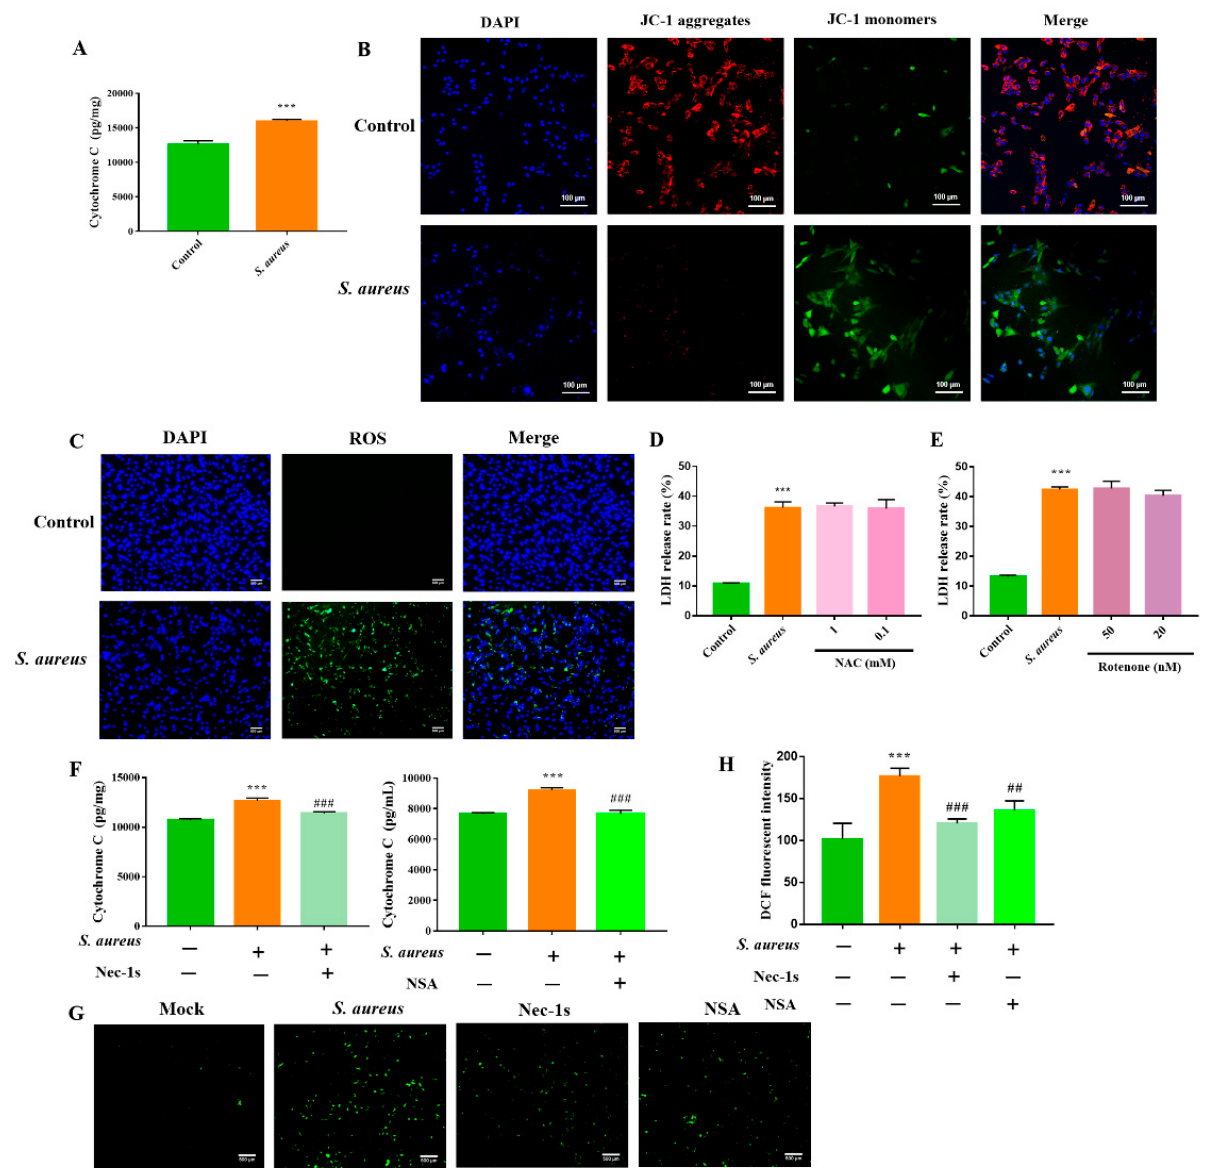
Figure 5. gEEC necroptosis aggravated the mitochondrial damage and ROS generation induced by S. aureus . ( A ) gEECs were infected with 10 MOI S. aureus for 4 h, then lysed cells, followed by cytochrome C levels detection using the ELISA assay. ( B ) After infection with S. aureus for 4 h, mitochondrial membrane potential was determined by JC-1 staining. Red represents the J-aggregates and green represents the monomer. ( C ) Fluorescence microscope analysis of ROS-DCFHDA was performed to detect the generation of ROS in S. aureus -infected gEECs. ( D , E ) gEECs were pretreated with the intracellular ROS inhibitor (NAC) and mitochondrial ROS inhibitor (rotenone), respectively, for 2 h, and then infected with 10 MOI S. aureus for 4 h. Then the release of LDH was detected using a CytoTox96 ® non-radioactive cytotoxicity assay kit. ( F , G ) gEECs were pretreated with a RIPK1 inhibitor (Nec-1s), RIPK3 inhibitor (GSK’872), and MLKL inhibitor (NSA) for 2 h, then infected with S. aureus for 4 h, followed by cytochrome C and ROS detection with the ELISA assay and a ROS assay kit. ( H ) The DCF fluorescent intensity. *** p < 0.001 vs. control group, ## p < 0.01, ### p < 0.001 vs. S. aureus group.